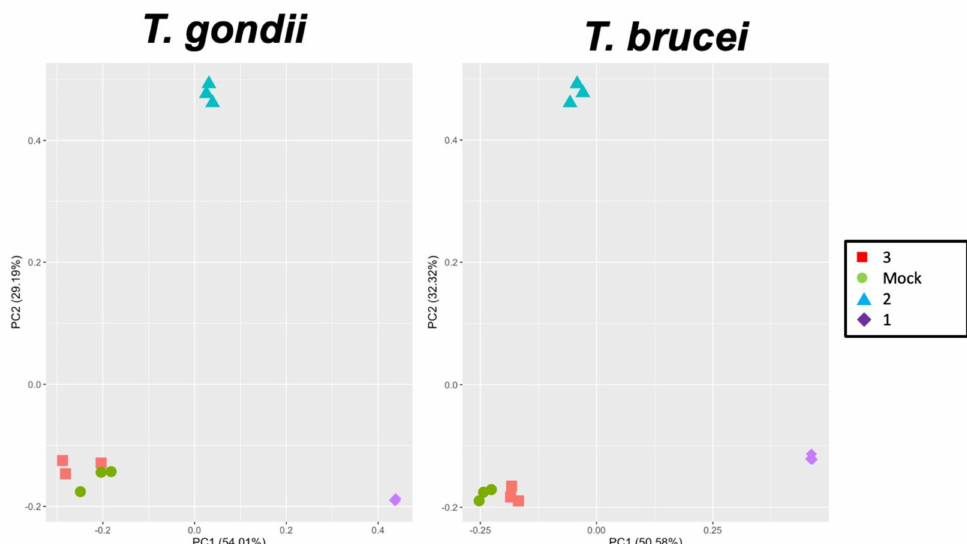
Figure 6. Principal component analysis of proteome dataset from differential pull–downs. Pull–down fractions of cell–free extracts from T. gondii and T. brucei from mock, 3 , 2, or 1 columns were compared by MS shotgun analysis as described in Materials and Methods. The LFQ values of technical replicates are shown.